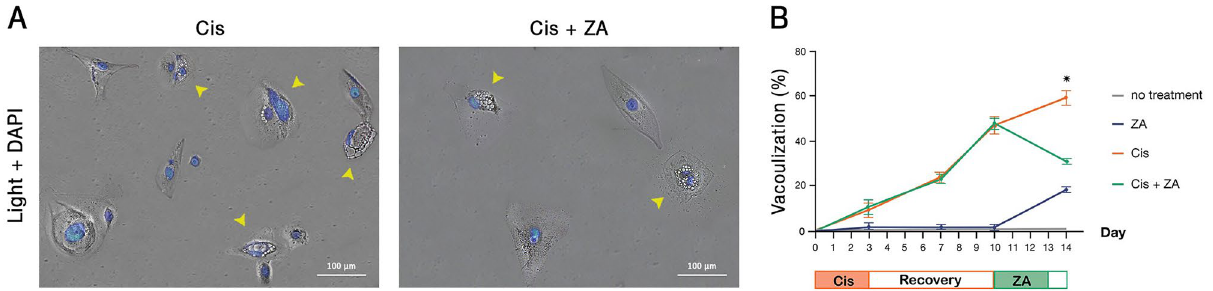
Figure 6. Cytoplasmic vacuolization is a common morphology in cisplatin-induced PGCCs. ( A ) Representative images of vacuolated cells (arrowheads) in cisplatin and cisplatin + ZA treated groups are shown. Nuclei are stained with DAPI. ( B ) Time-series quantification of microscopic observations in three independent experiments demonstrated the accumulation of these vacuoles in cisplatin-treated cells. The asterisk indicates the significant decline of these vacuoles in Cis + ZA group compared to Cis ( p- value < 0.05); error bars: mean ±